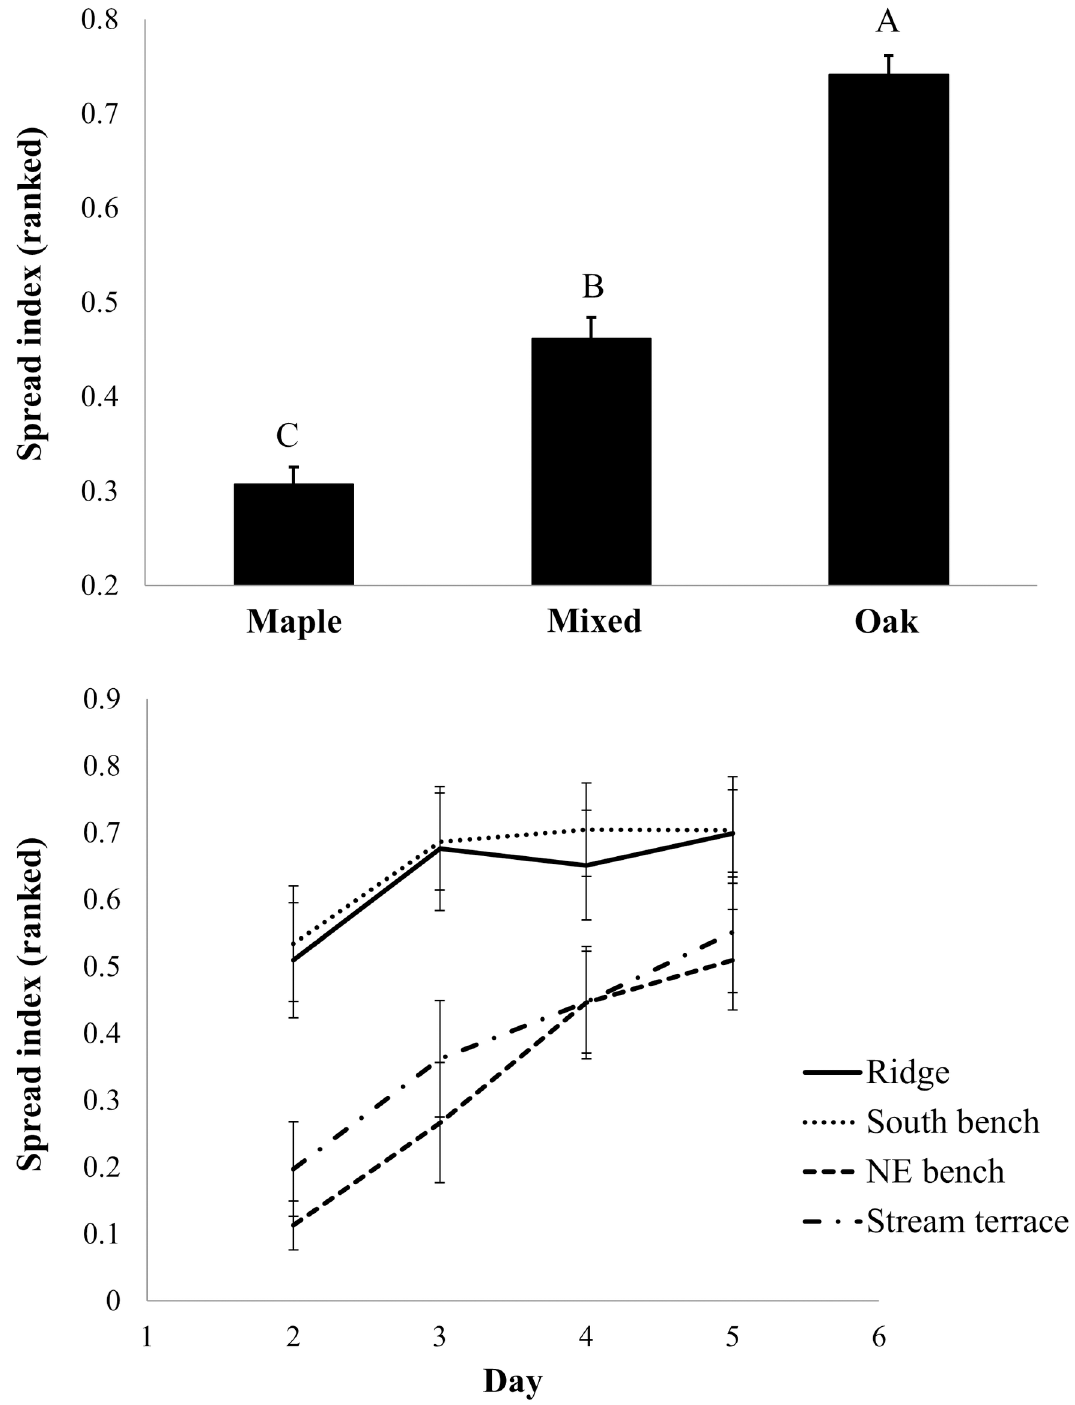
Fig 10. Fire spread potential for common garden fuel beds. Rank spread index is shown as a function of litter source, topographic position, and day during the dry-down. The spread index was parameterized with data from laboratory combustion trials [9] and applied to common garden fuel beds based on measurements of fuel bed, fuel particle, and combustion characteristics. Standard errors are shown.